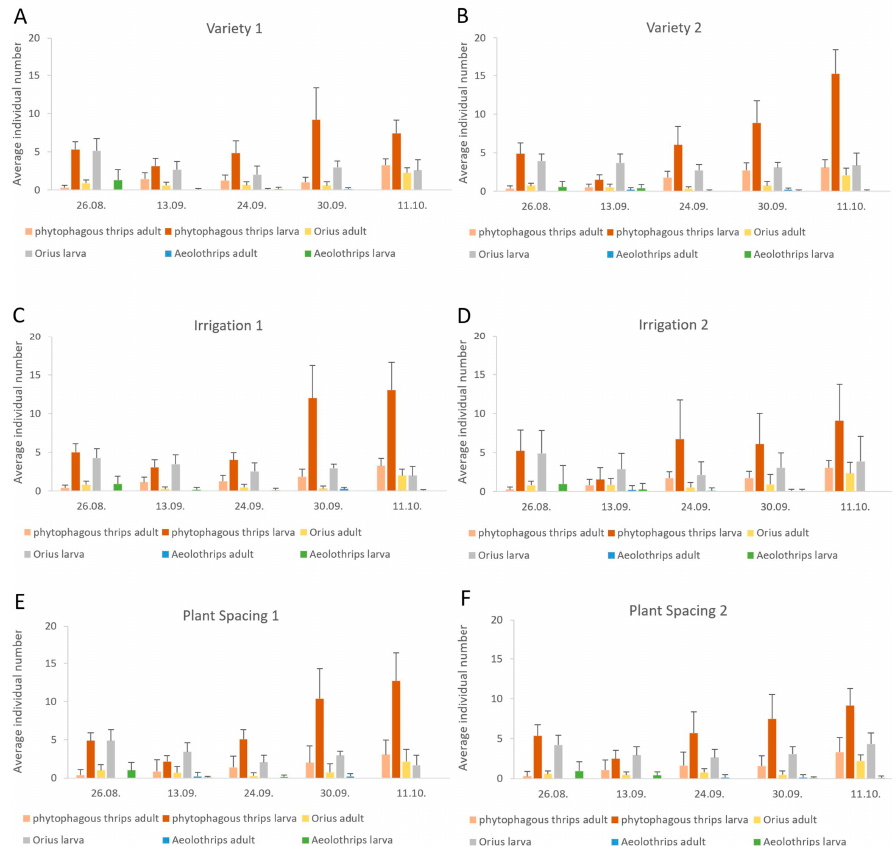
Figure 5. Seasonal dynamics of predatory and phytophagous insects in chili pepper flowers in 2021. ( A ) Trinidad Scorpion Butch T. ( B ) Yellow Scotch Bonnet. ( C ) Irrigation daily, 40 min. ( D ) Irrigation every second day, 20 min. ( E ) Increased plant spacing. ( F ) Decreased plant spacing. The error bars represent the standard errors.